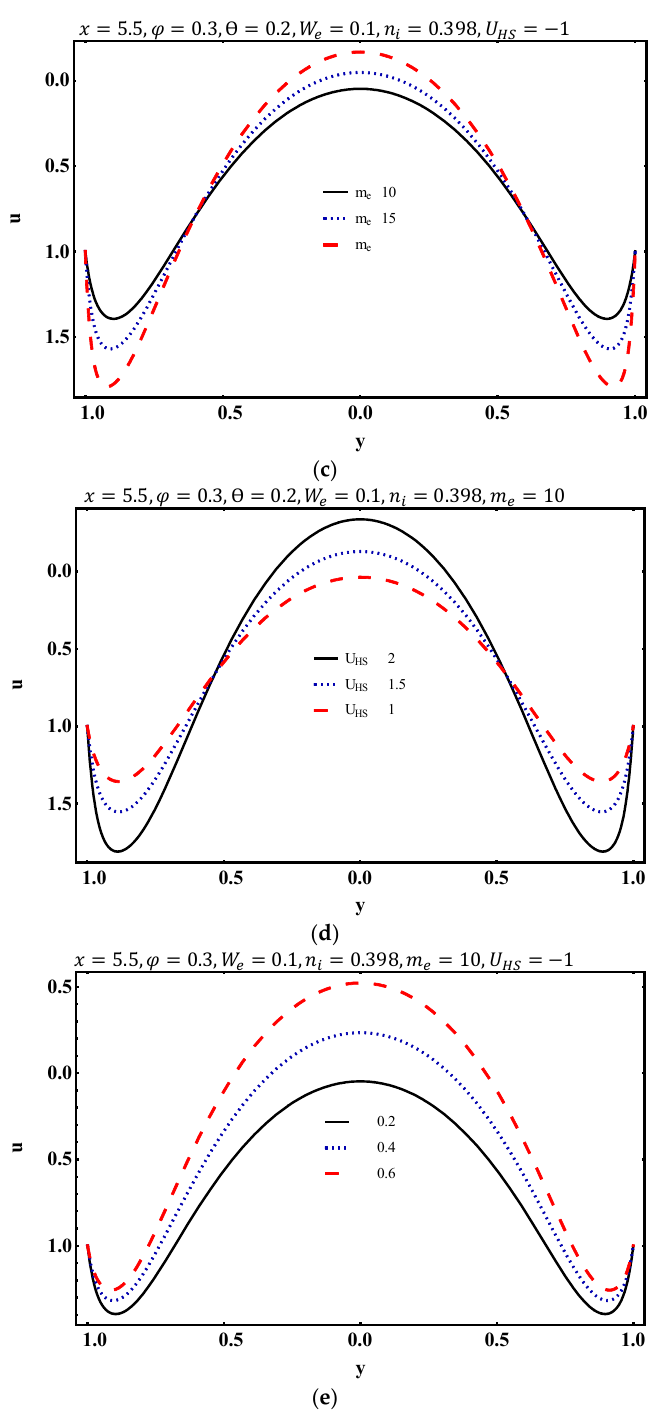
Figure 2. Axial velocity u profile for (cid:4666)𝐚(cid:4667) . 𝑊 (cid:3032) (cid:4666)𝐛(cid:4667).𝑛 (cid:3036) (cid:4666)𝐜(cid:4667).𝑚 (cid:3032) (cid:4666)𝐝(cid:4667).𝑈 (cid:3009)(cid:3020) (cid:4666)𝐞(cid:4667).ϴ .